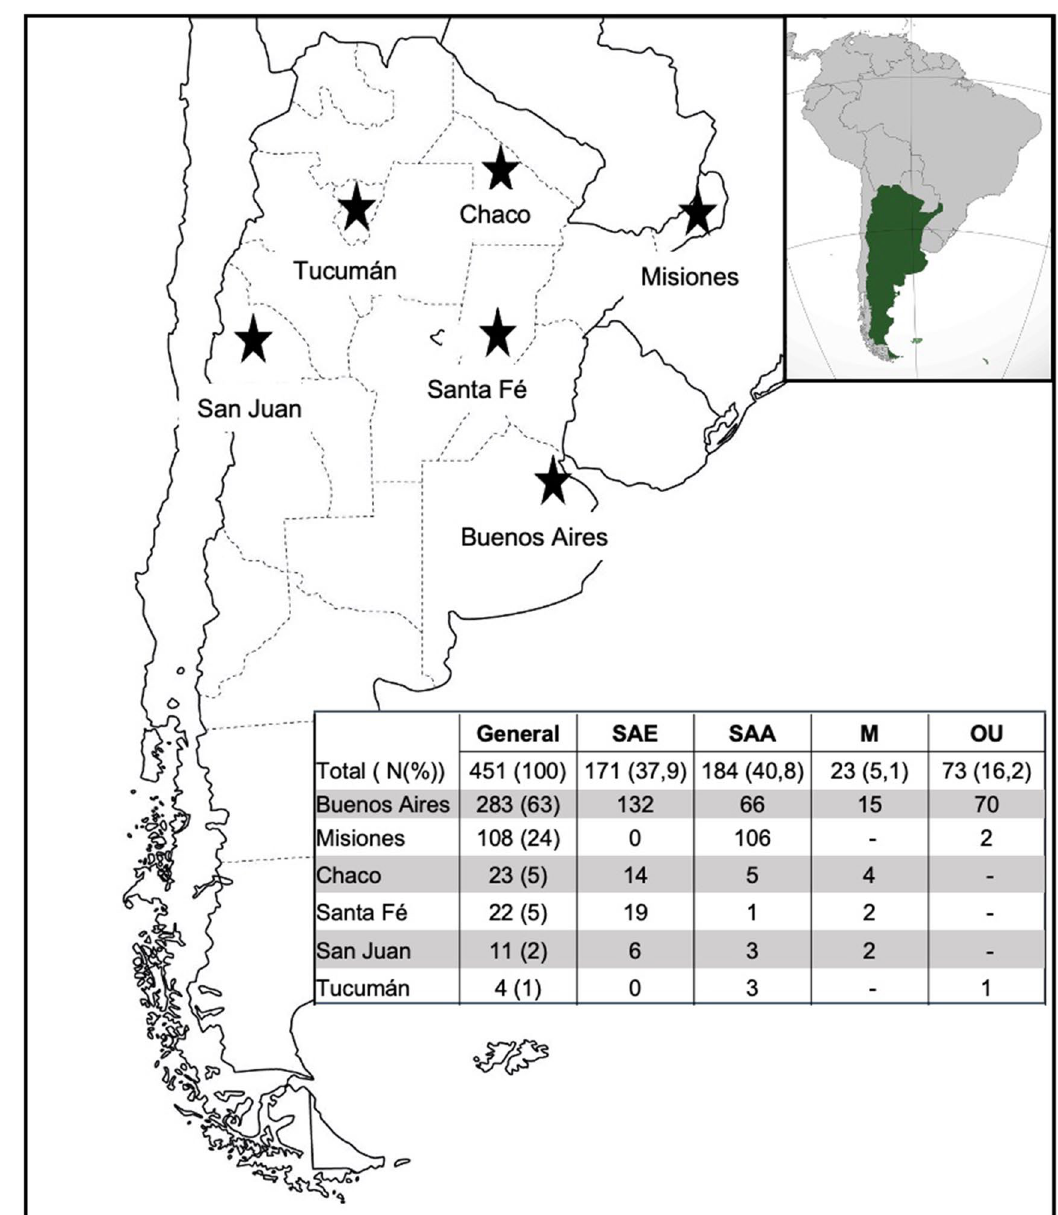
Figure 1. Geographic localization of UCB donations in Argentina and ancestral population groups. Map of Argentina showing the 24 provinces highlighting (stars) the 6 provinces where UCB units were collected. The upper inset shows Argentina´s localization within South America. Table inset shows the number of units collected in each province corresponding to each of the 4 population groups: SAE) South American of European descent, SAA) South American of Amerindian descent, M) Mixed SAE and SAA population, OU) Other mixed or Unknown